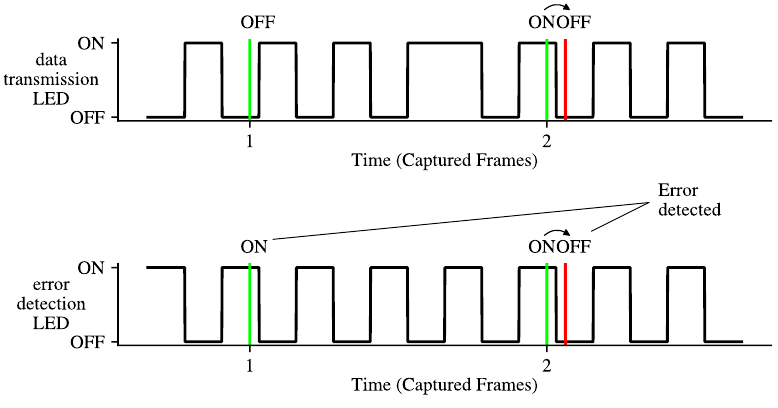
Figure 8. UDPSOOK with Error Detection, based on [3].